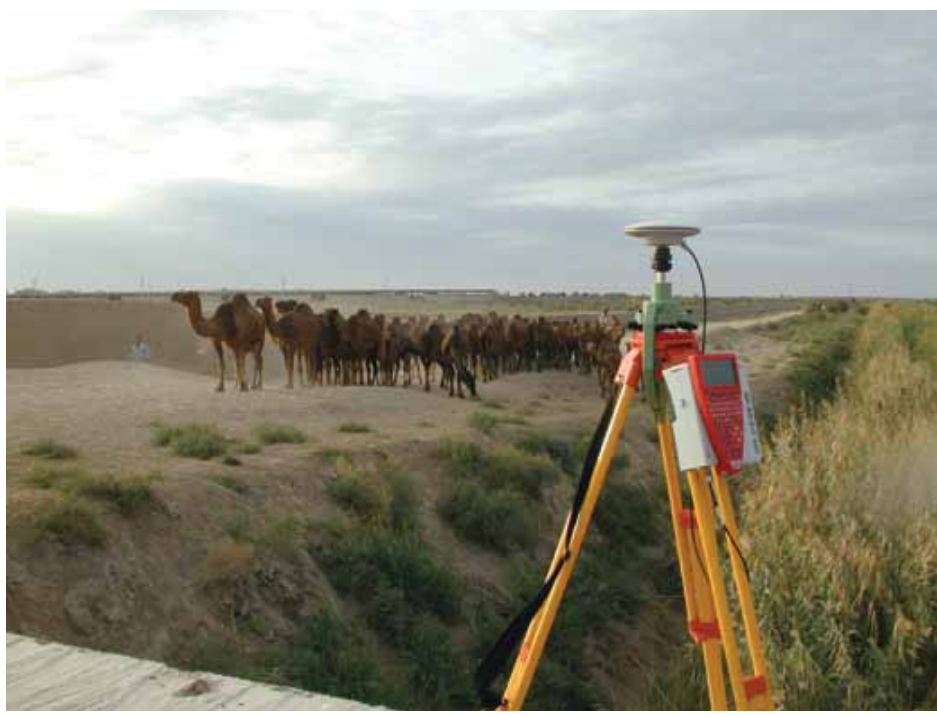
Fig. 5: The Lecia Global Positioning System (GPS) set up to establish a control point, on one of the road bridges near Ancient Merv, to geo-reference the IKONOS satellite image.